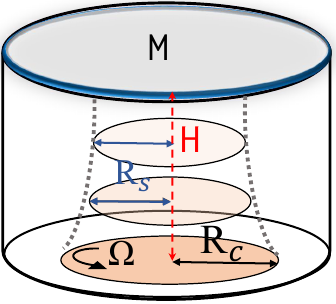
Figure 1. Schematic sketch of the experimental setup. In the split-bottom Couette cell, the bottom plate is divided into two parts: the stationary outer part ( r > R C ) and the rotating inner part (with the angular velocity Ω ). The Loading weight M is a thick transparent plexiglass plate, placed on the top of the granular pile. Dotted lines show the location of shear band R s inside the bulk for shallow filling heights.